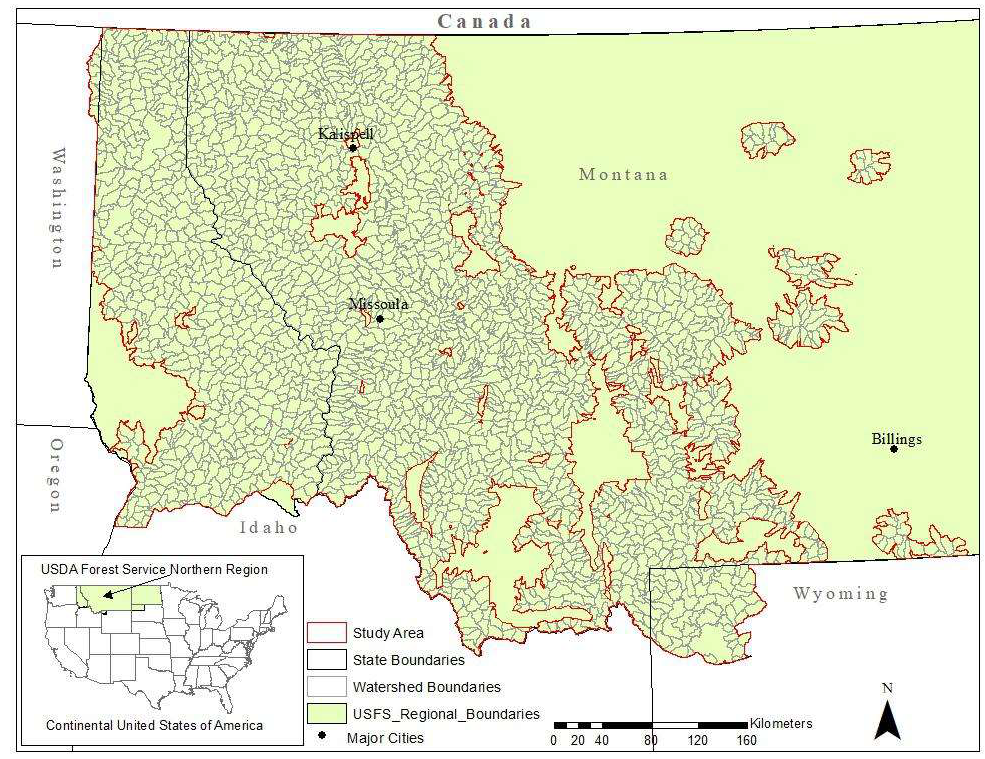
Figure 1. Study area boundary of lodgepole pine forests.